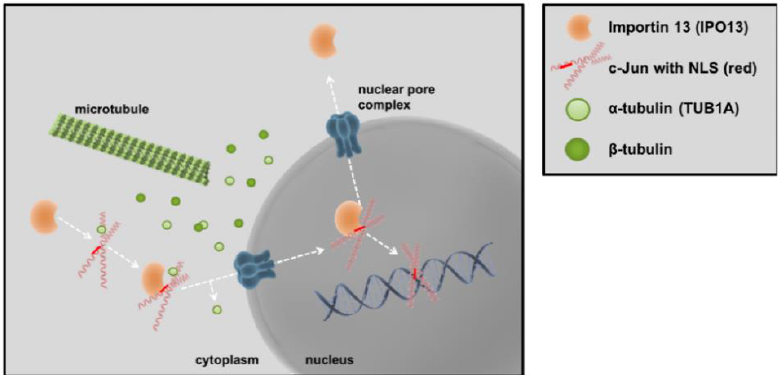
Figure 4. Schematic overview of the c-Jun/TUB1A/IPO13 complex in melanoma cells. Monomeric α- tubulin (TUB1A) stabilizes the transcription factor c-Jun for nuclear transport via importin 13 (IPO13). The complex assembly of c- Jun, TUB1A, and IPO13 occurs in a nuclear localization sequence (NLS)- dependent manner, however, TUB1A remains in the cytoplasm whereas c-Jun translocates into the nucleus via IPO13, and hence, affects AP-1 activity in melanoma